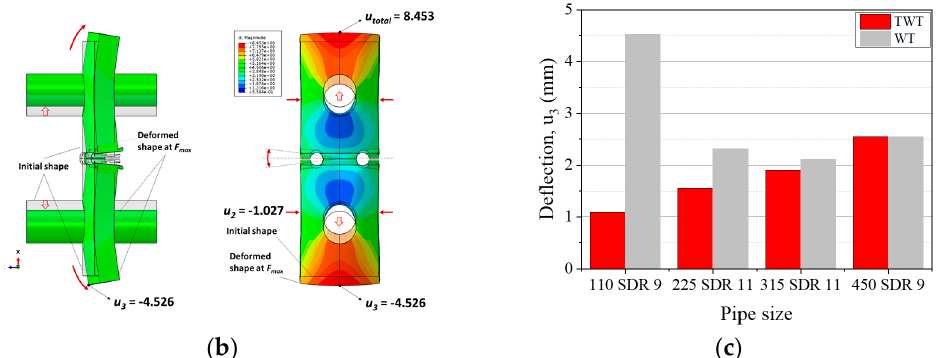
Figure 19. Transverse deflection of 110 SDR 9 WT specimen: ( a ) Experimental; ( b ) FEA result at F max (unit: mm); ( c ) Comparison of u 3 between TWT and WT specimens at F max .